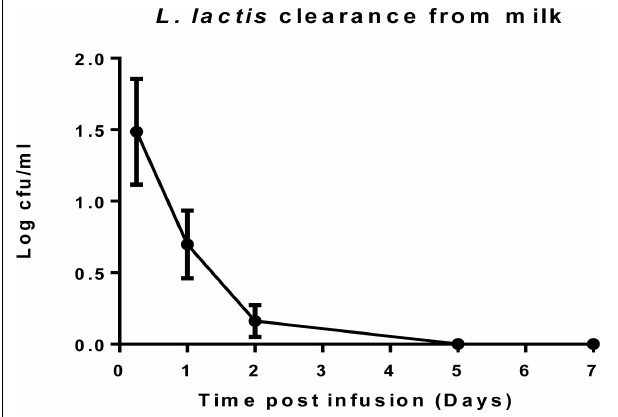
FIGURE 5 | L. lactis DPC3147 clearance from milk. Determination of the rate of clearance of L. lactis DPC3147 from milk samples from a selection of cows treated with the ‘live bio-therapeutic’ formulation in emulsion. Graph shows mean values and standard error of mean